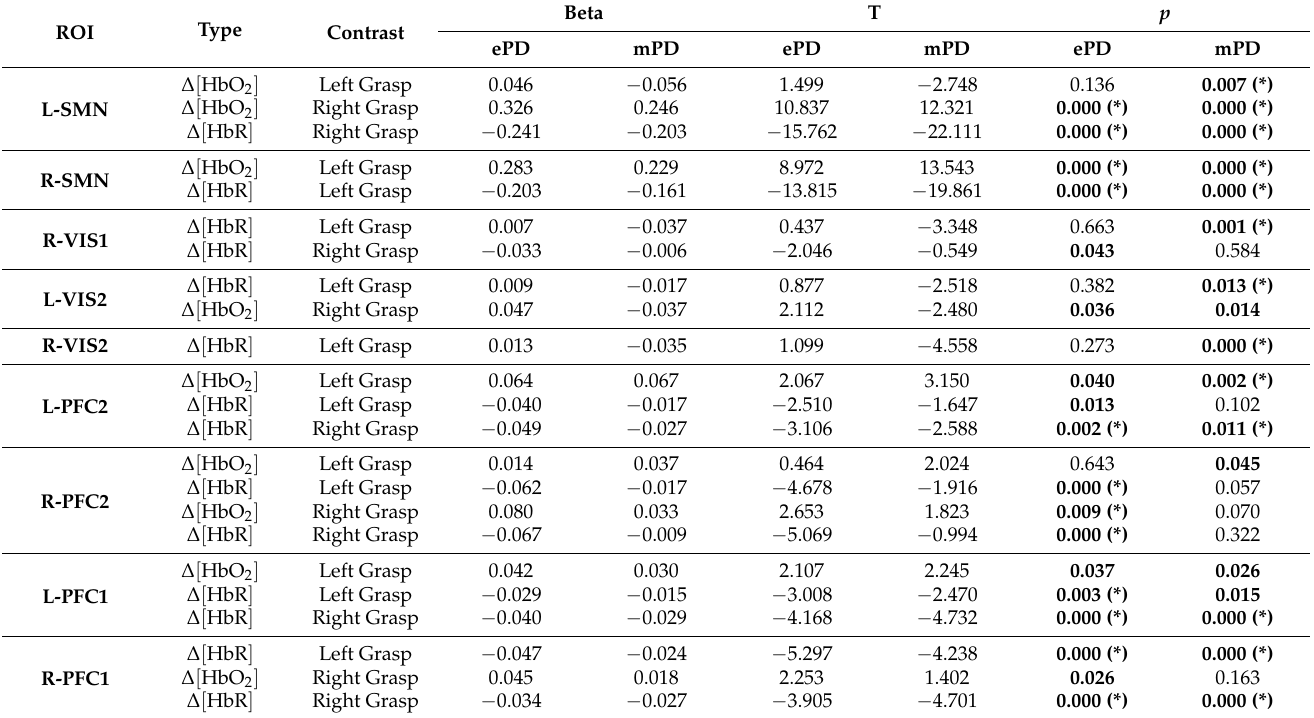
Table 2. Significant group-level results for the ePD and mPD groups across ROIs, task condi- tions, and chromophores. (*) significant results for p FDR < 0.05. Left hemisphere (L-); right hemi- sphere (R-); sensorimotor network (SMN); primary visual network (VIS1); secondary visual network (VIS2); dorsolateral prefrontal cortex (PFC1); ventrolateral prefrontal cortex (PFC2). Bold highlights significant comparisons.